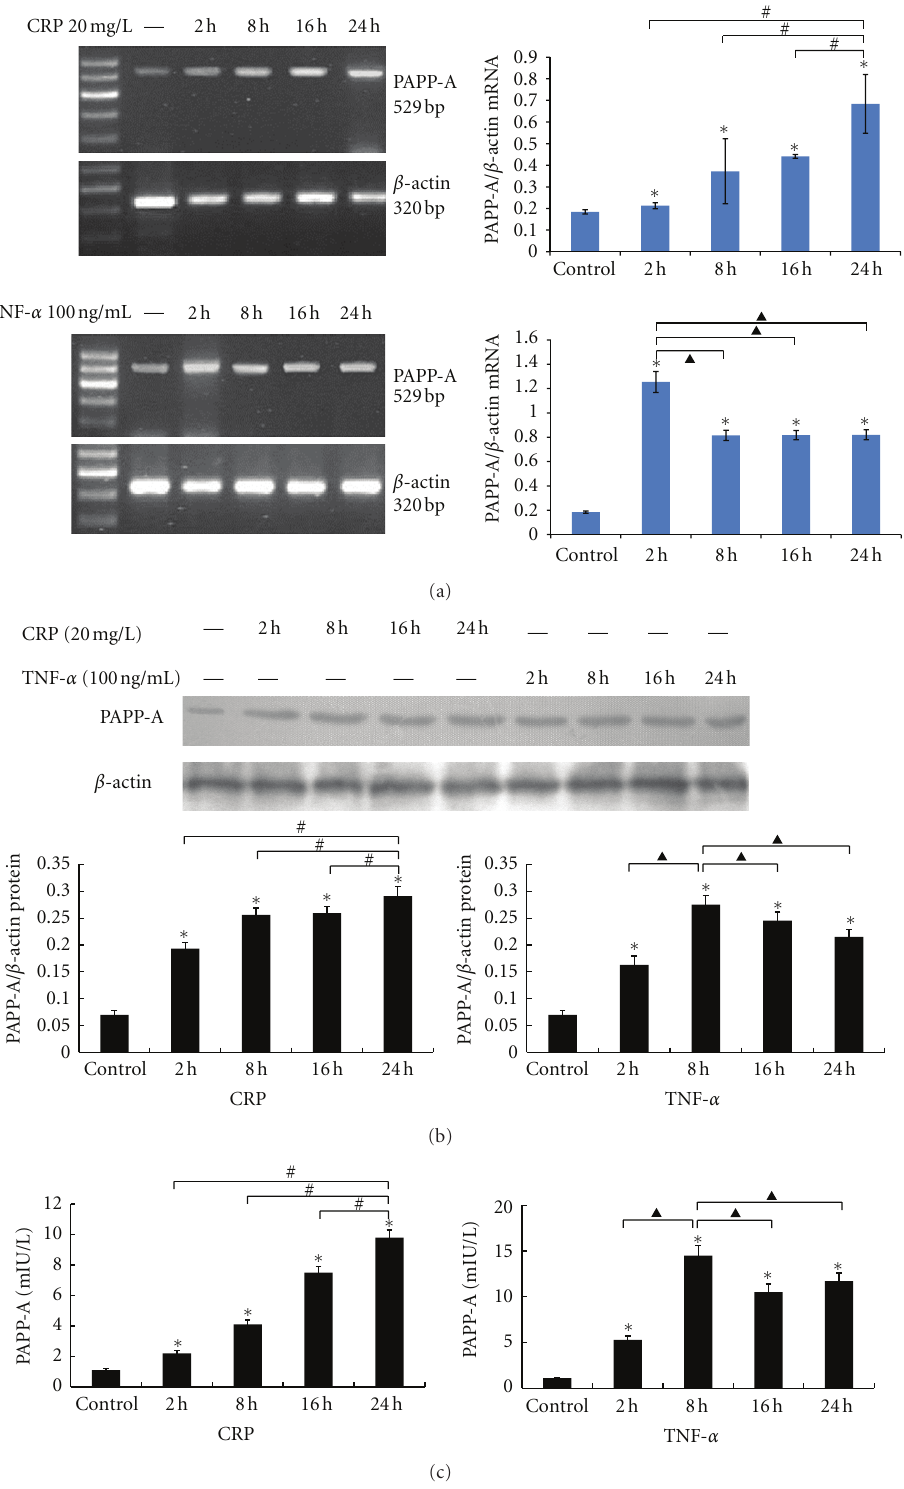
Figure 1: PBMCs were stimulated with CRP or TNF- α for 2, 8, 16, 24 hours. (a) PAPP-A mRNA were measured using RT-PCR. (b) PAPP-A protein expression were measured by western blotting. (c) Culture supernatant was collected respectively to analyze PAPP-A concentration by an ultra-sensitive ELISA. The resultant data are expressed as the means ± SD of six donors. ∗ : P < 0 . 05 compared with the control. #: P < 0 . 05 compared with the PBMCs stimulated with CRP for 24 hours; (cid:2) : P < 0 . 05 compared with the PBMCs stimulated withTNF- α for 2 hours or 8